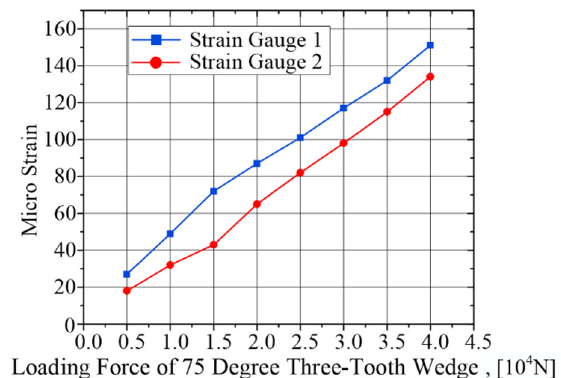
Table 3. The strain values of each measuring point are under different loading force of 75° three-tooth wedge teeth.